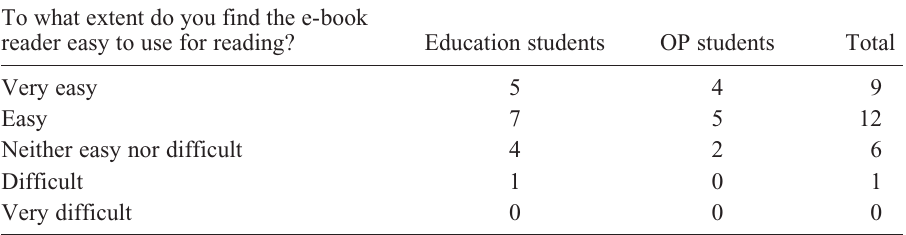
Table 9. To what extent do students find the e-book reader easy to use for reading materials? To what extent do you find the e-book reader easy to use for reading?